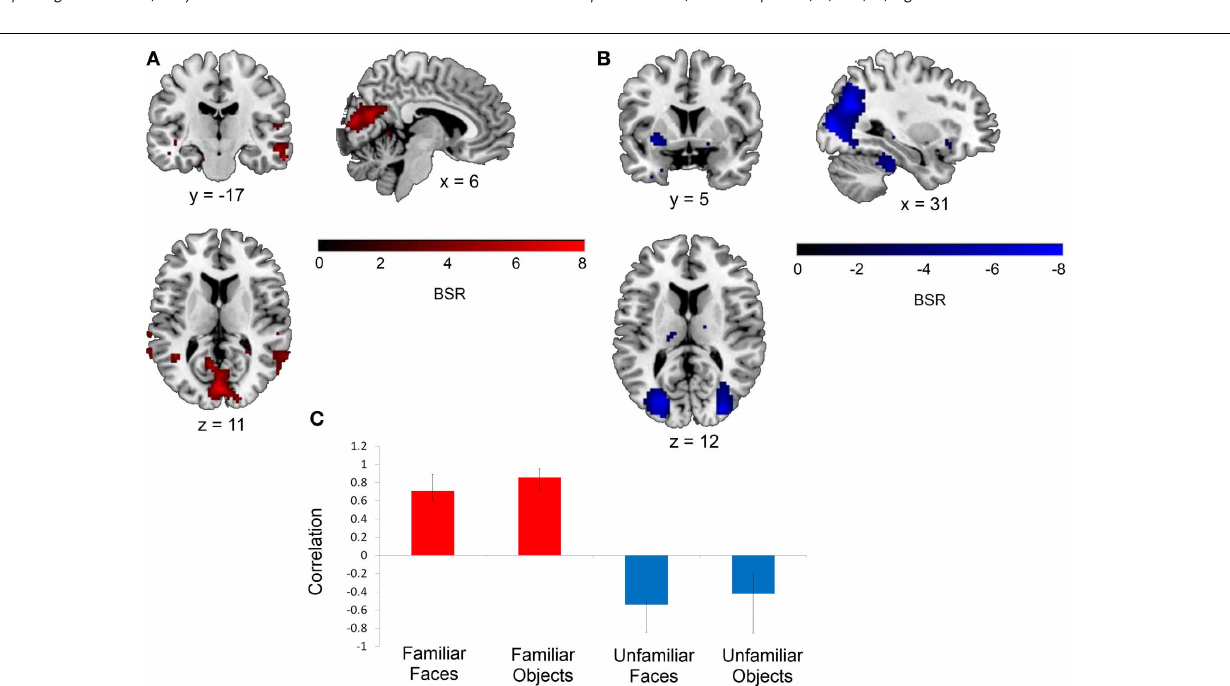
which the seed was correlated during the two unfamiliar conditions in TR 3. The bar graph in (C) depicts the correlation of the signal in the anterior hippocampal seed with the two networks during the four experimental conditions. Maps are thresholded at the equivalent of p < 0 . 05 for visualization purposes. BSR, bootstrap ratio. Error bars reflect 95% confidence intervals.